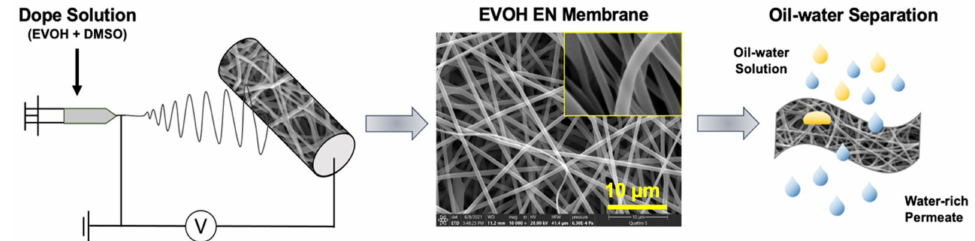
Figure 2. Fabrication of the hydrophilic EVOH nanofibrous membrane and its application for oil– water separation. Table 1. Composition of the spinning solution and the electrospinning conditions. Dope Solution for